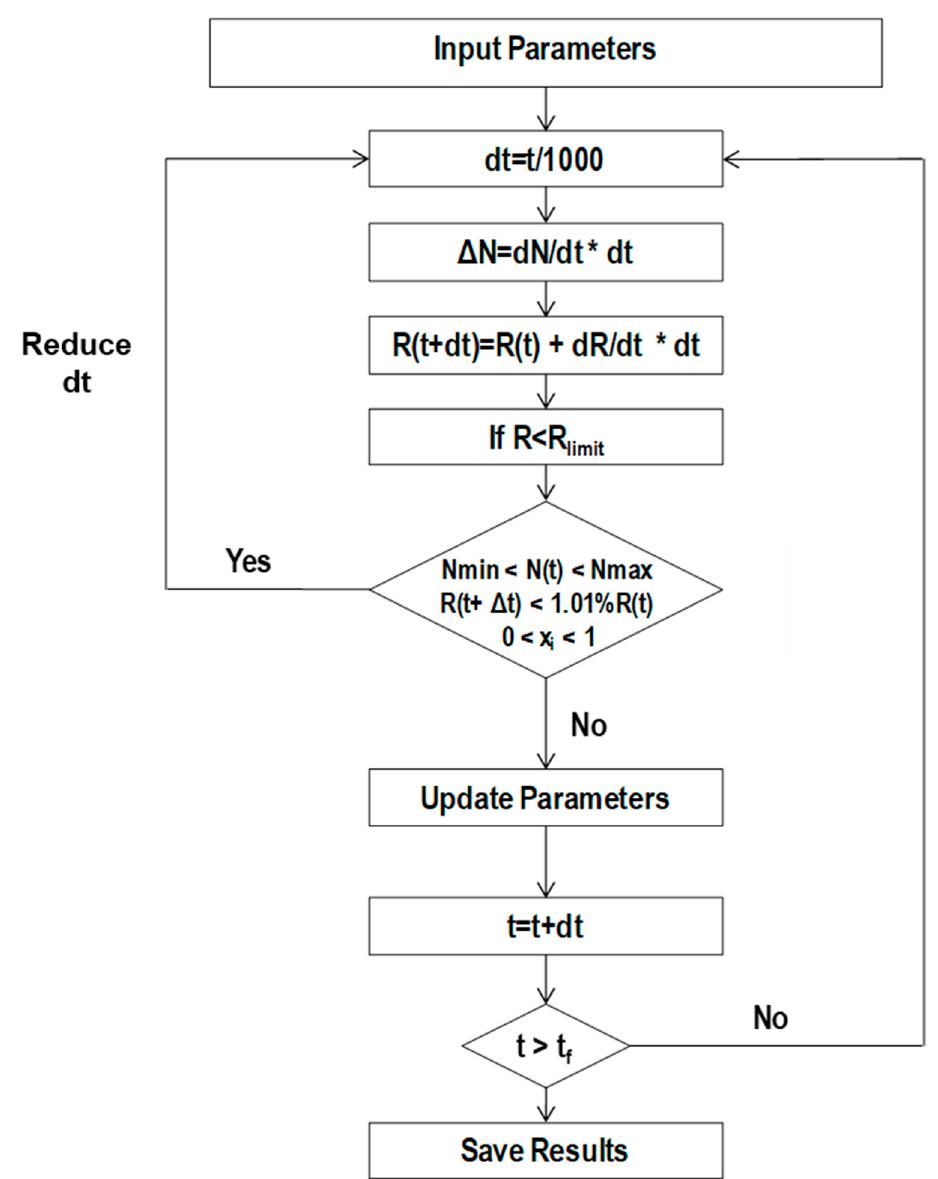
Figure 2. Flow chart of the integrated precipitation and strengthening model.